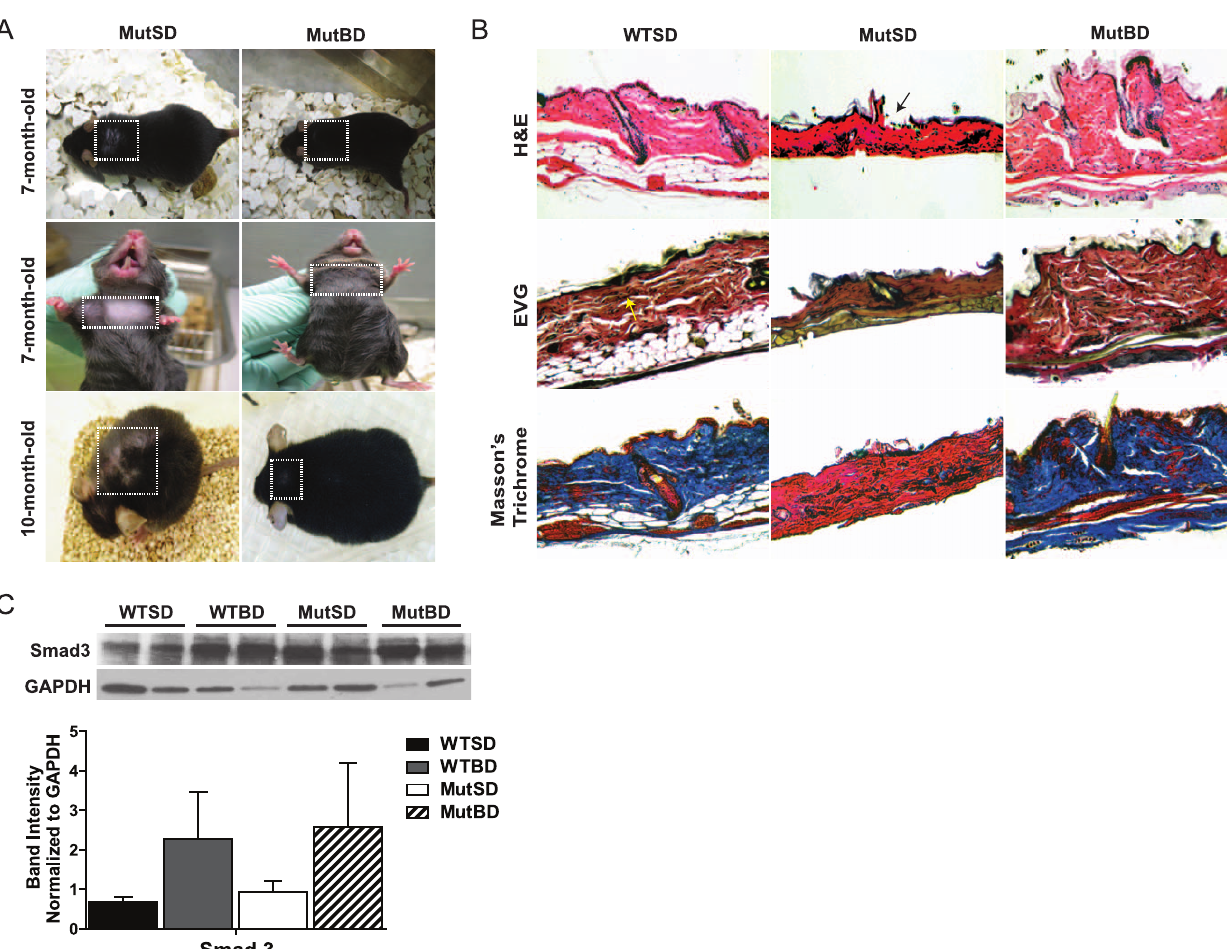
Figure 2. Bezafibrate delayed hair loss and restored the skin structure of Mut mice. (A) Pictures of mice at 7 month-old and 10 month-old showing their coat phenotype (n=6/group). Squares highlight area of coat being described. (B) Dorsal skin sections from 10 month-old mice showing hematoxylin and eosin (H&E) staining to depict structural changes (black arrow indicates break in the epidermis layer of MutSD mice), Verhoeff’s Van Geison (EVG) staining for elastic fibers shown in black/dark brown (yellow arrow) and Masson’s trichrome staining showing collagen in blue (n=2/ group). (C) Western blot showing total Smad3 and glyceralgehyde 3-phosphate (GAPDH) protein levels in total skin homogenate from 10 month-old mice and quantification of total Smad3 band intensity normalized to GAPDH (n=4/group). Error bars represent the